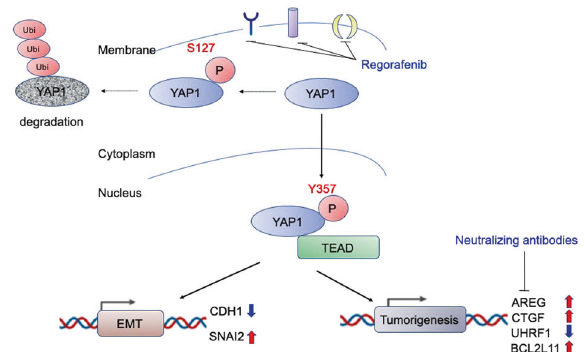
Fig. 8 Schematic model of this study. Evidence was pooled to illustrate the combined approach as a potential treatment option targeting YAP1-AREG axis for CCA